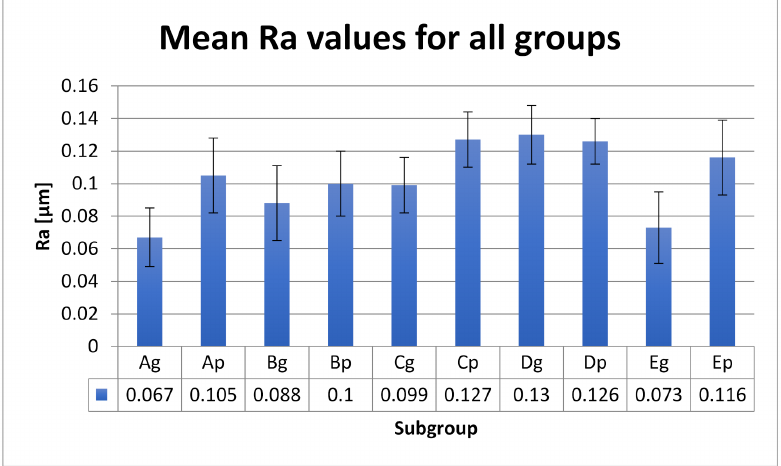
Figure 5. Ra values (mean ± SD) for all tested groups.